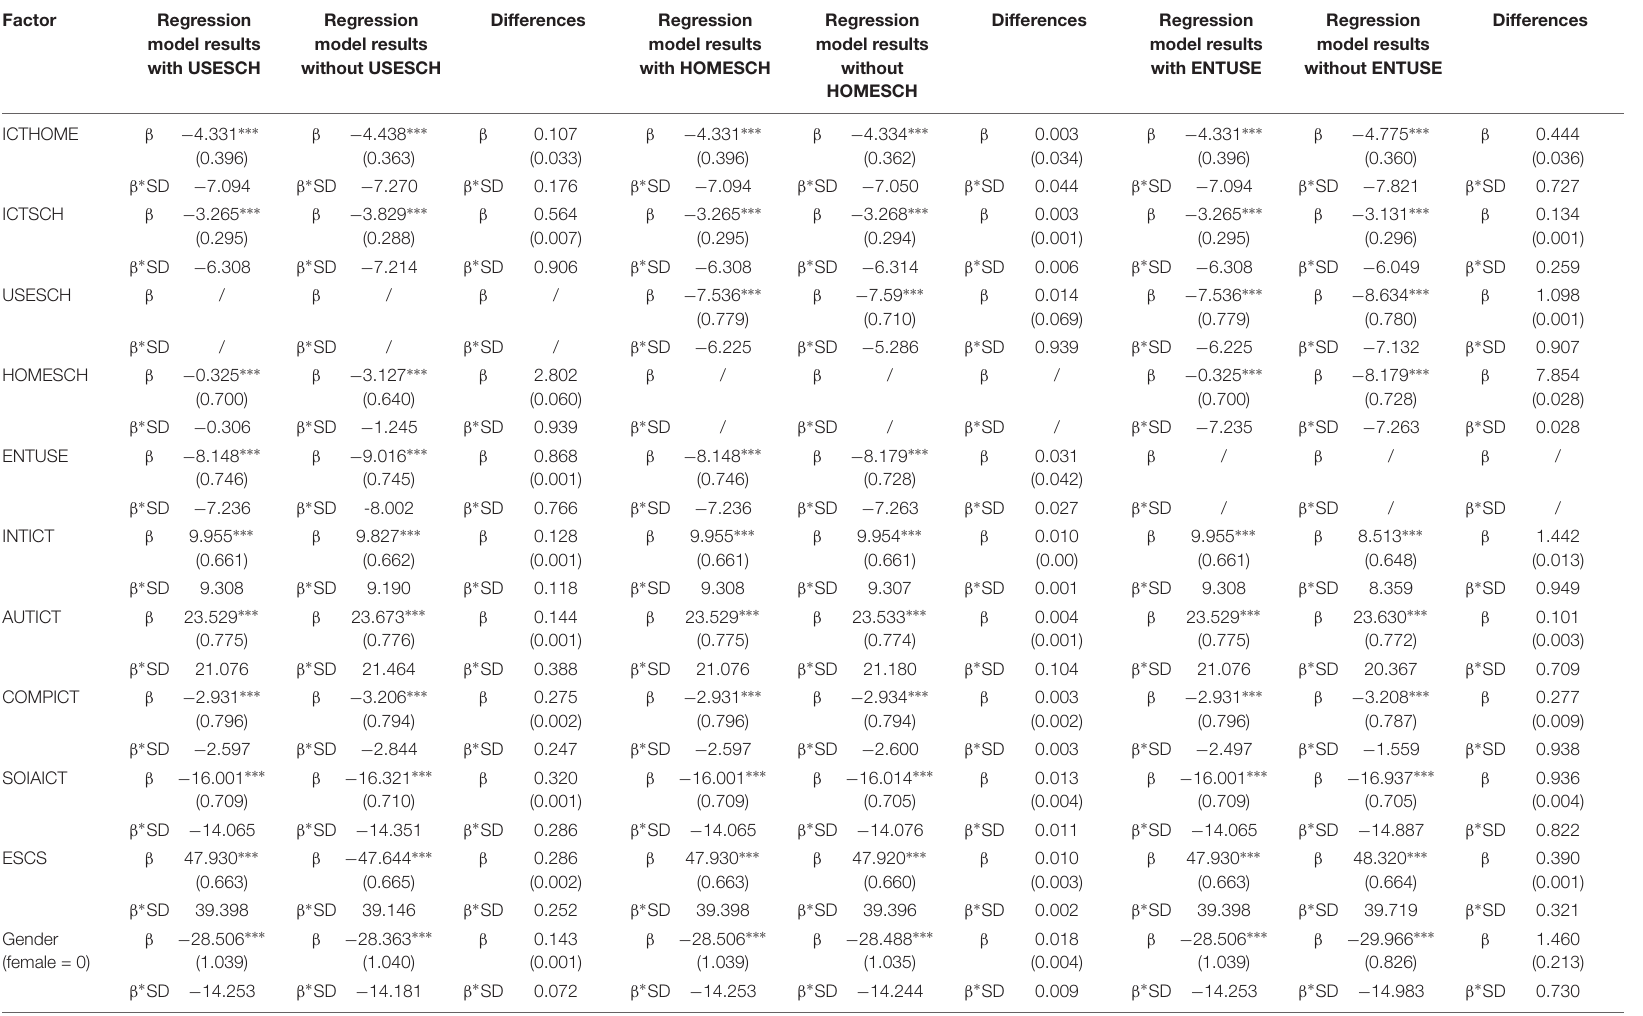
TABLE 4 | Comparison of the results of the regression models with and without each ICT use factor of USESCH, HOMESCH, and